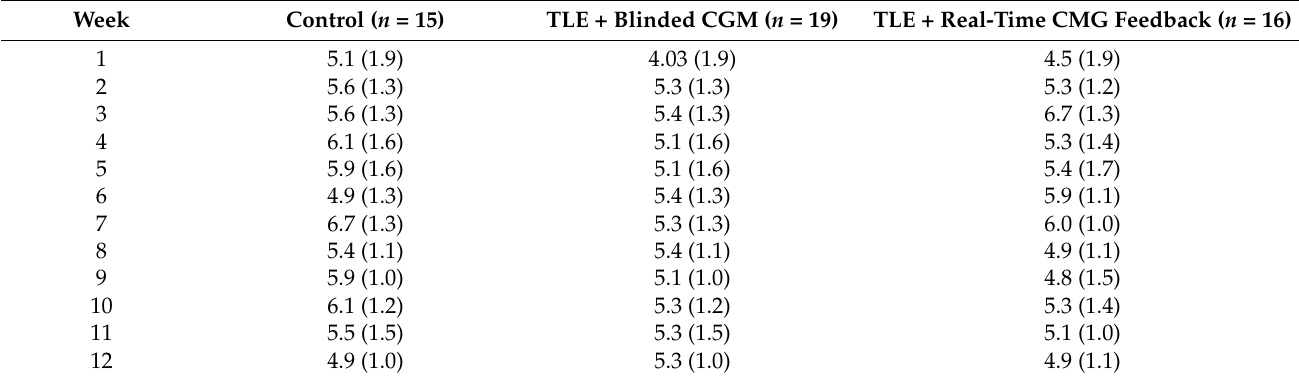
Table 2. Mean number of days (SD) in which the assigned eating window was completed across intervention arms using intention to treat with carry forward of the last weeks